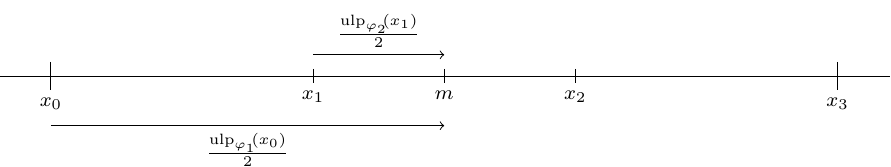
( x ), ◦ 1 ( x ) = ◦ ↓ ϕ 1 ( x ), implying ◦ 1 ( ◦ 2 ( x )) = ◦ ↓ ϕ 1